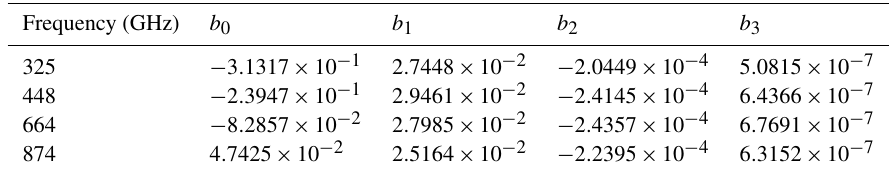
Table A2. Coefficients in the fitting of terahertz single-scattering albedo.